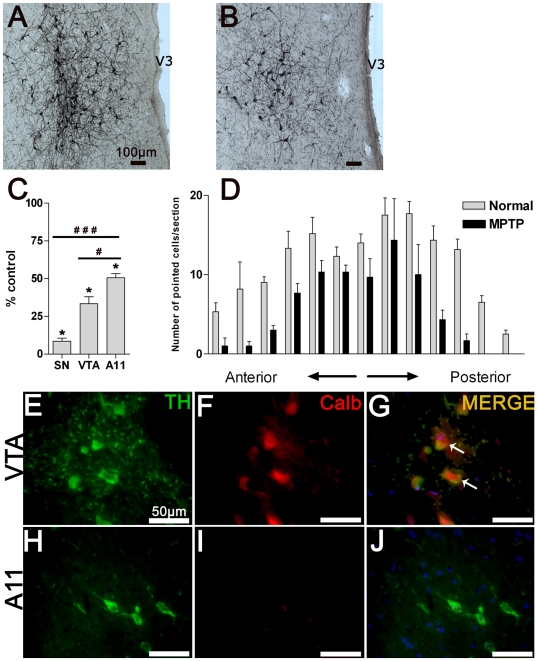
Effect of the neurotoxin MPTP on hypothalamic A11 neurons.
A. Representative microphotograph of TH-IR A11 neurons in a control animal. B. Representative microphotograph of TH-IR A11 neurons in an MPTP-intoxicated animal with full parkinsonism. Note the large cell loss within the A11 area. C. Mean (±SD) percentage of total number of TH-IR neurons remaining following MPTP intoxication within the substantia nigra, ventral tegmental area and A11 group (*P<0.0005, comparison between MPTP-treated animals (n = 2) and control animals (n = 4); #
P<0.02 and ###
P<0.0003, comparison between dopaminergic groups following MPTP intoxication, two-tailed P value, unpaired t-test). Note the difference in cell loss following MPTP intoxication between the A11 group and the various DA regions. D. TH-IR counted cells were mapped in individual sections from anterior to posterior hypothalamic A11 area with 200 µm section intervals. Note the general cell loss at different levels of the A11 area in MPTP-treated animals (n = 2) compared to controls (n = 4). E–J: Representative micrograph of TH (green) and CALB (red) double fluorescent immunostaining obtained under a confocal laser-scanning microscope in VTA (E–G) and A11 (H–J) sections. The white arrows point to typical double-stained neurons. Note the absence of CALB-positive neurons within the A11 region. Abbreviations: Calb = Calbindin 28 k; TH = Tyrosine Hydroxylase; V3 = Third Ventricle.